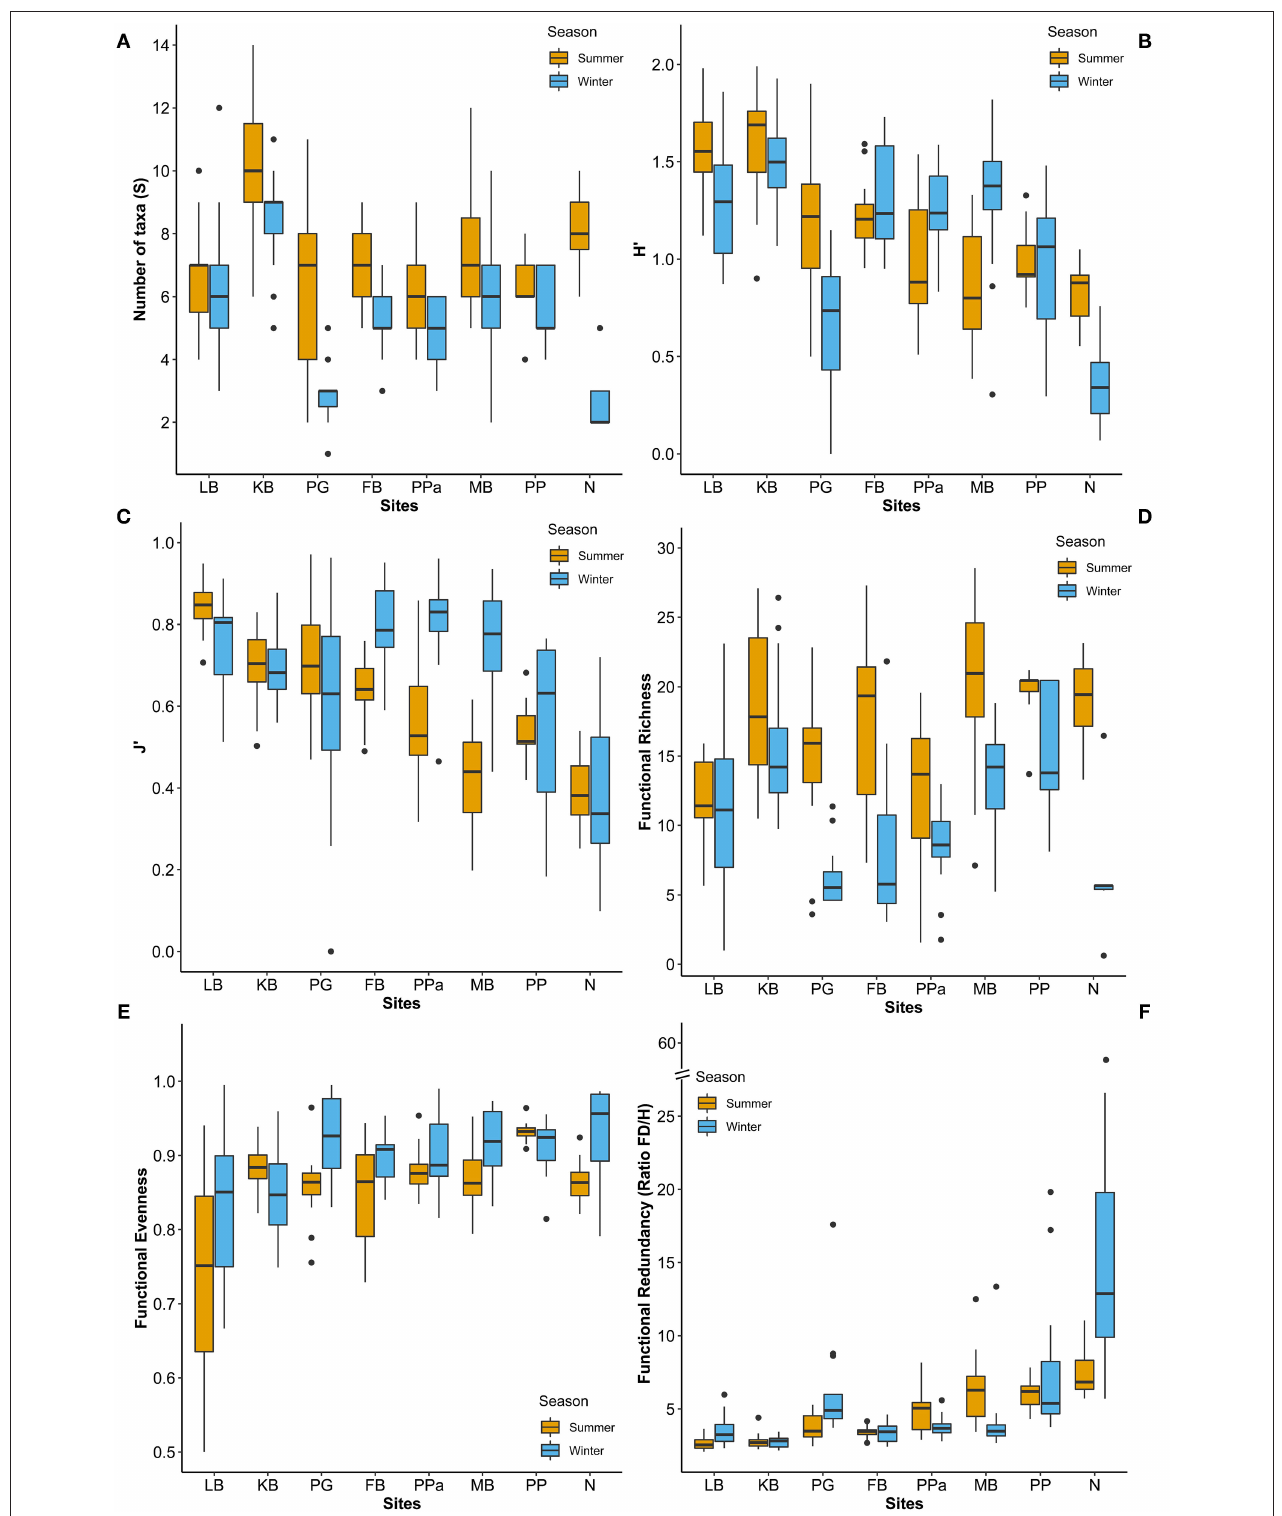
FIGURE 3 | Box plots of (A) number of taxa (S), (B) Shannon diversity index (H’), (C) Pielou’s evenness index (J’), (D) Functional Richness, (E) Evenness, and (F) Redundancy across sites and seasons. LB, Long Beach; KB, Kellidie Bay; MB, Middle Beach; PPa, Port Parham; PG, Port Germein, FB, Fisherman Bay; PP, Pelican Point; N,